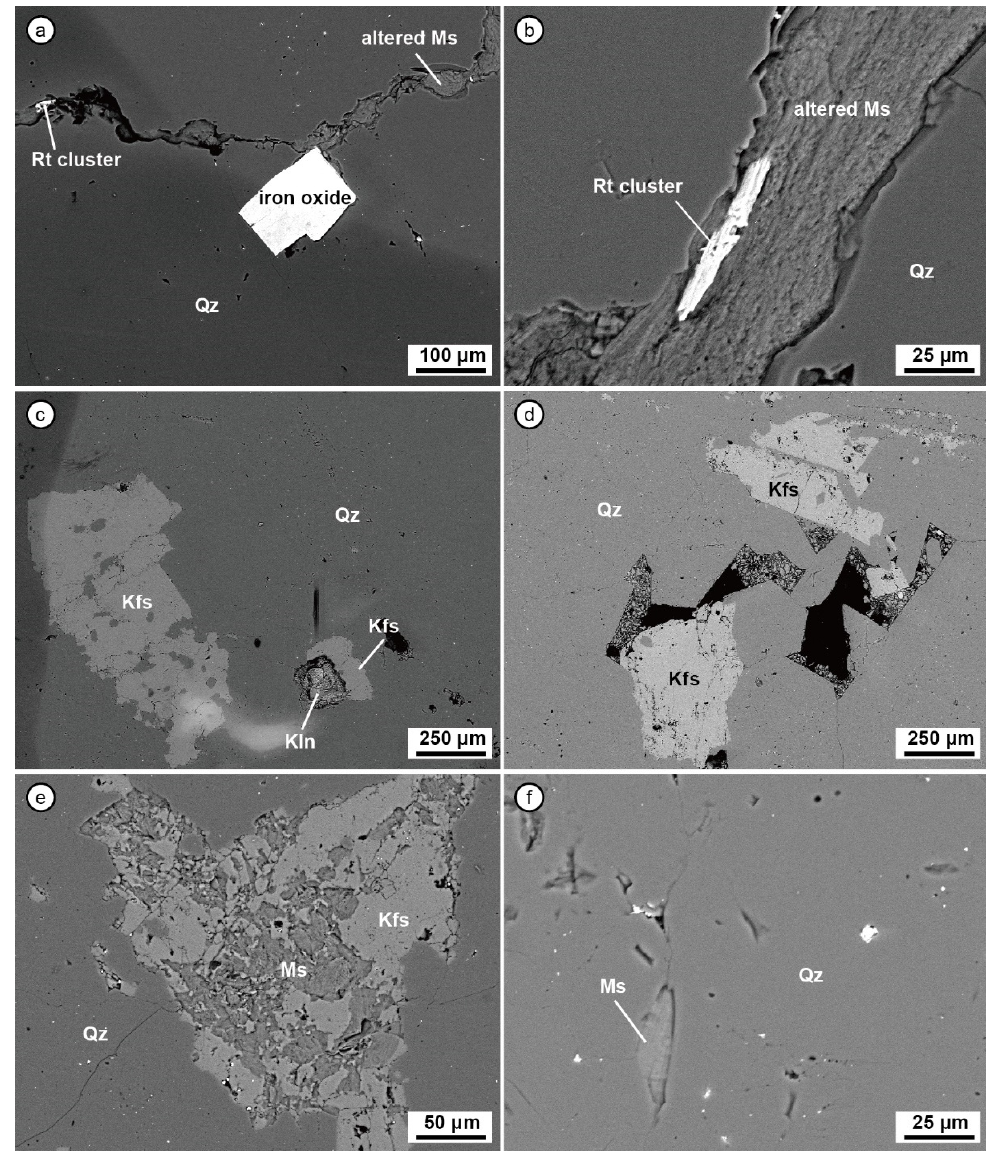
Figure 5. Backscattered electron images of micro-inclusions in the raw quartz from Fujiashan and Yipanqiu veins; ( a ) altered muscovite, rutile cluster, and iron oxide inclusions in quartz from the Fujiashan-II vein; ( b ) altered muscovite and rutile cluster occur along the grain boundary in the Fujiashan-II vein quartz; ( c ) K-feldspar crystal and co-occurred kaolinite (presumably weathered product of K-feldspar) inclusions incorporated into the Fujiashan-I vein quartz; ( d ) ubiquitous K- feldspar inclusions in quartz at Zimudong locality from the Yipanqiu deposits; ( e ) inclusions of K- feldspar in paragenesis with muscovite in quartz at Renyou locality from the Yipanqiu deposits; ( f ) Muscovite inclusion in quartz at Renyou locality from the Yipanqiu deposits. Qz = quartz, Ms = muscovite, Rt = rutile, Kln = kaolinite, Kfs = K-feldspar.